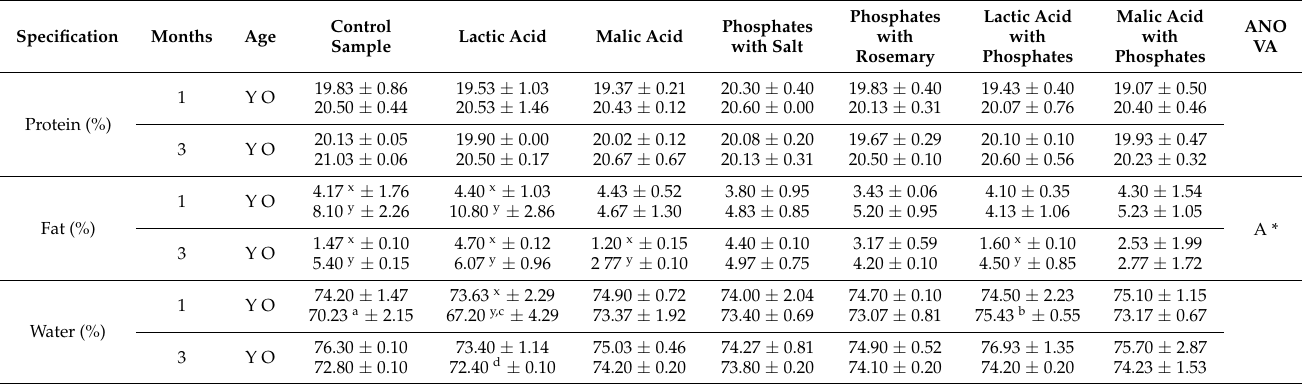
Notes: a,b different letters in the same row indicate statistically significant differences between the control sample and the samples marinated with selected substances ( p < 0.05). x,y Different letters in the same column indicate statistically significant differences between the age groups of horses in particular periods of frozen storage ( p < 0.05). c,d Different letters in the same column indicate statistically significant differences between the periods of frozen storage in particular age groups of horses ( p < 0.05). ANOVA: three-way ANOVA; A, age of animal. * p < 0.05. Y and O denote younger and older horses,